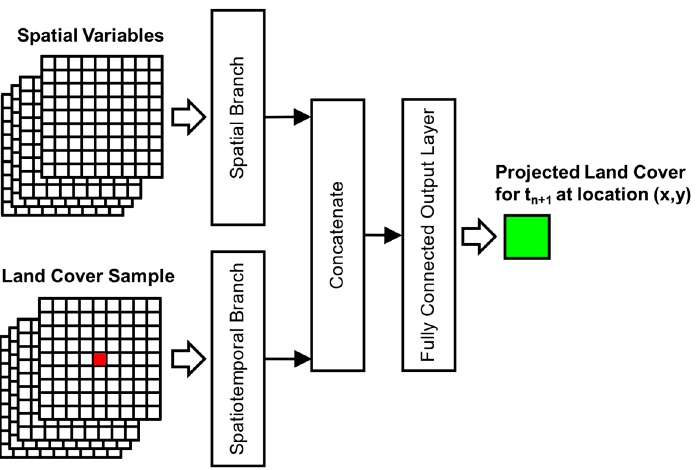
Figure 2. Overview of the basic branched model structure used to accommodate the 9 × 9 spatiotemporal land cover sample sequences and the auxiliary spatial variables. The “spatial branch” is implemented with CNN layers. The “spatiotemporal branch” implementation varies according to the model type, characterized by CNN-LSTM, CNN-GRU, CNN-TCN, or ConvLSTM layers. Location x, y in the land cover sample is denoted in red, indicating the central cell of the neighborhood.